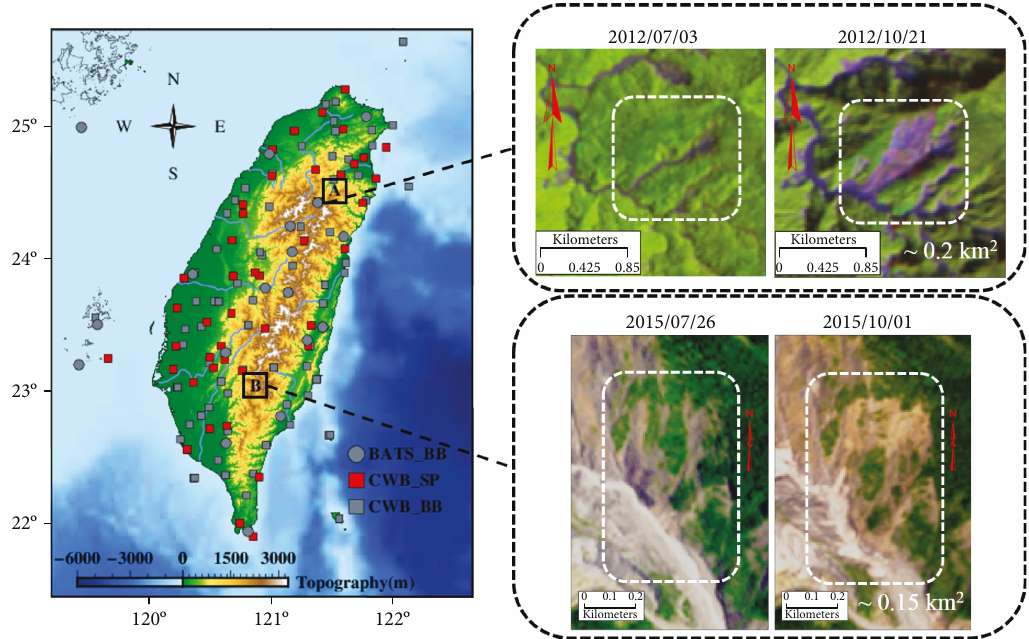
Figure 8: Prior/post landslide satellite images of the two landslide events during the 2012 Typhoon Saola and the 2015 Typhoon Soudelor. Locations of these two landslides determined using our seismic system are shown in Figure